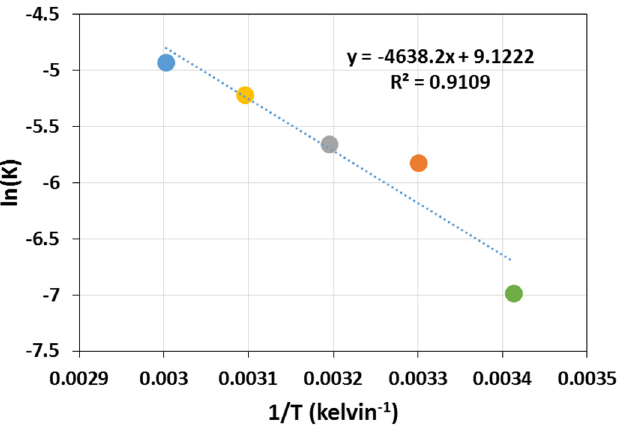
Figure 11. Arrhenius plot to calculate the activation energy (Ea) for Pt-ZSM-5 catalyst.